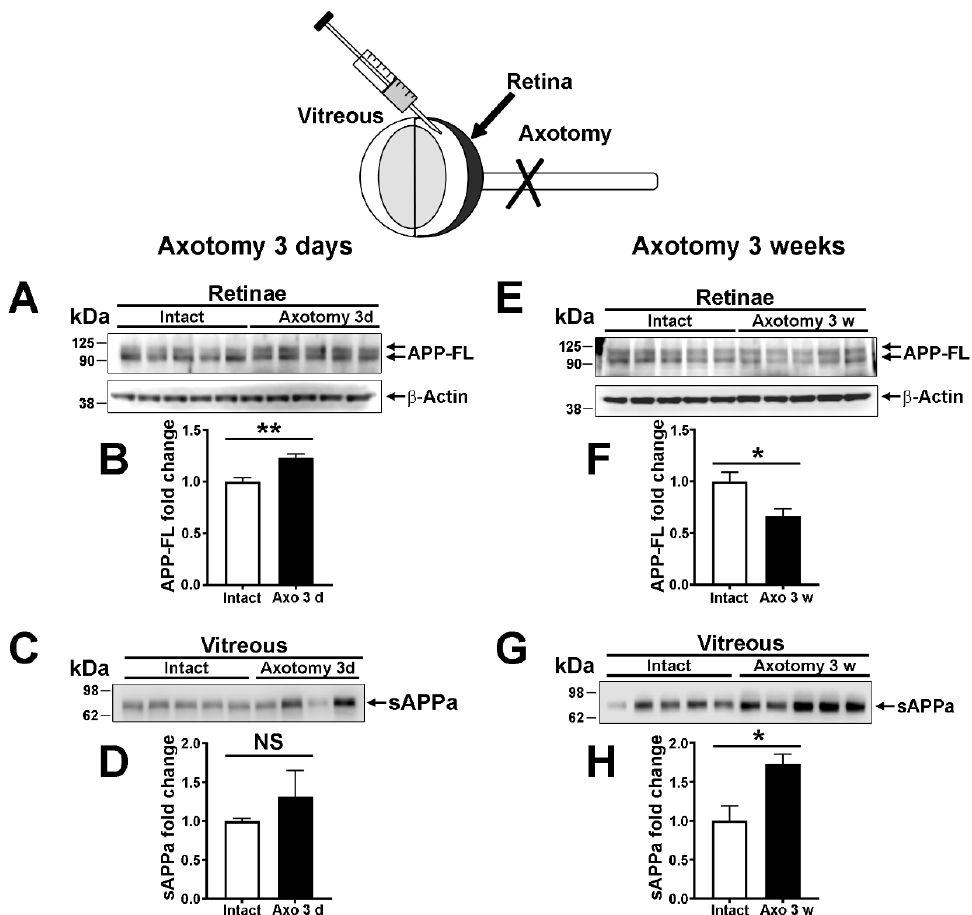
Figure 4. Nonamyloidogenic transformation of APP in the retina does not depend on retinal ganglion cells. The optic nerve injury paradigm was used to selectively eliminate retinal ganglion cells (RGCs) in WT retinae. Vitreous samples were withdrawn from the eyeball under anesthesia using a 10- µ L Hamilton syringe. ( A , B ) Three days after optic nerve injury, a time when injured RGCs are not yet lost, APP-FL was significantly upregulated in retina lysates compared with intact conditions (unpaired t -test, **: p < 0.01). ( C , D ) In the vitreous, sAPP α was not significantly increased (NS). ( E , F ) Three weeks post-injury, the level of APP-FL was significantly decreased in lesioned retinae compared with intact ones (unpaired t -test, *: p < 0.05). ( G , H ) At the same age, the level of sAPP α was enhanced in the vitreous of injured mice (unpaired t -test, *: p < 0.05), suggesting that nonamyloidogenic products were secreted by α -secretase independently of